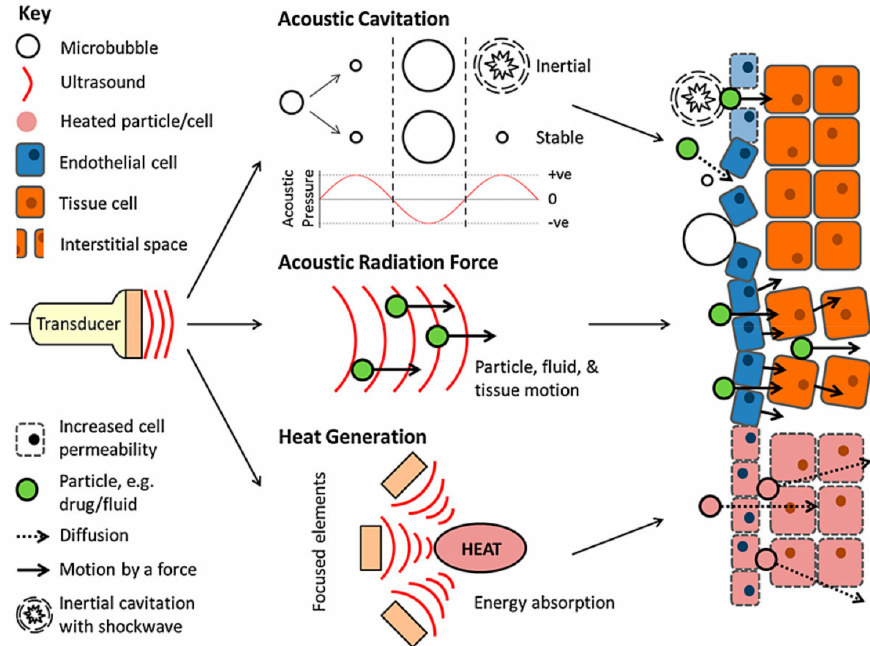
Figure 37. Ultrasound triggered release from microbubbles by mechanical effects by acoustic cavita- tion and thermal effects by acoustic radiation (reproduced from [167] with permission from Fluids , MDPI licensed under Creative Commons Attribution (CC BY 4.0)